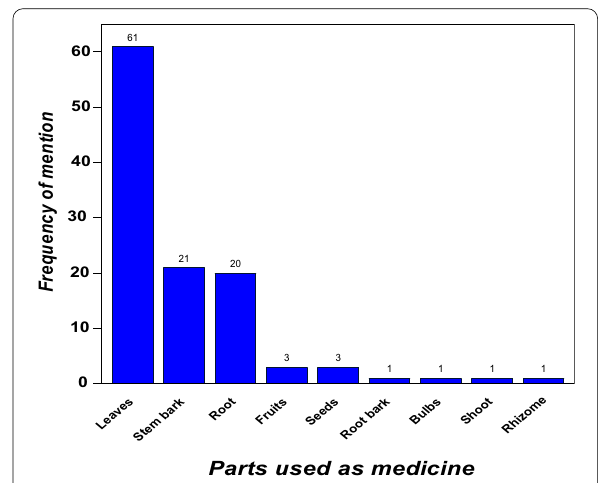
Fig. 2 Medicinal plant parts used to treat diarrhea and cough in Kampala city